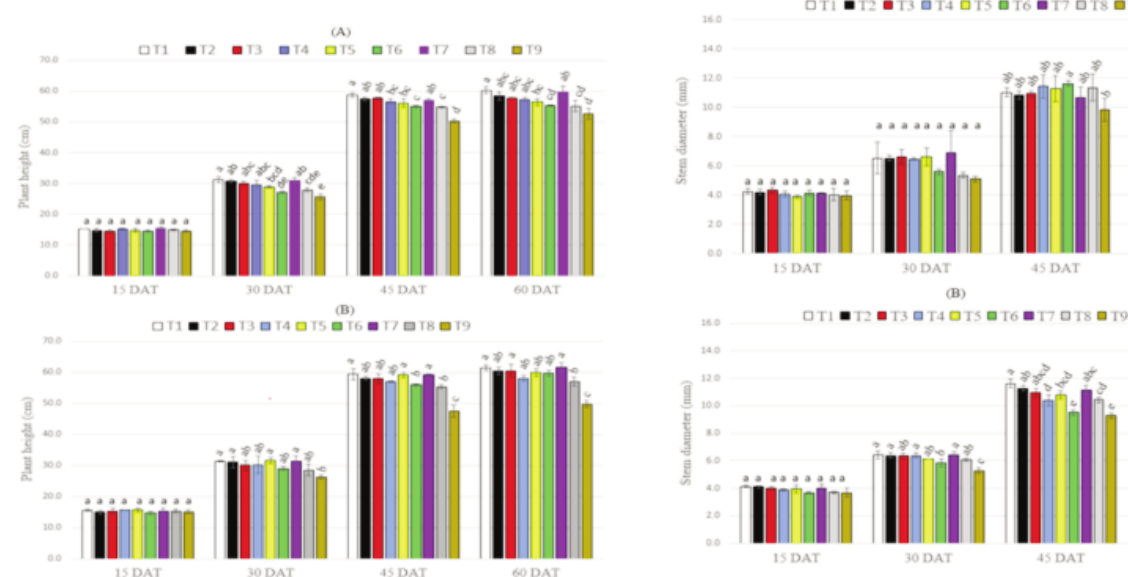
Fig. 2 ­ Stem diameter of tomato cv. Roma under different treat­ ments against Tuta absoluta in trials one (A) and two (B). T1: Steinernema sp. RW14­M­C2a­3, T2: Steinernema sp. RW14­M­C2b­1, T3: Metatech®WP ( Metarhizium aniso‐ pliae , Strain FCM Ar 23B3), T4: Beauvitech® WP ( Beauveria bassiana , Strain J25), T5: Tephrosia vogelii , T6: Phytolacca dodecandra , T7: azadirachtin 0.03% EC, T8: imidacloprid, T9: Water; DAT: Days after transplan­ ting; Different letters above the bars indicate significant difference according to Tukey’s test (p≤0.05).